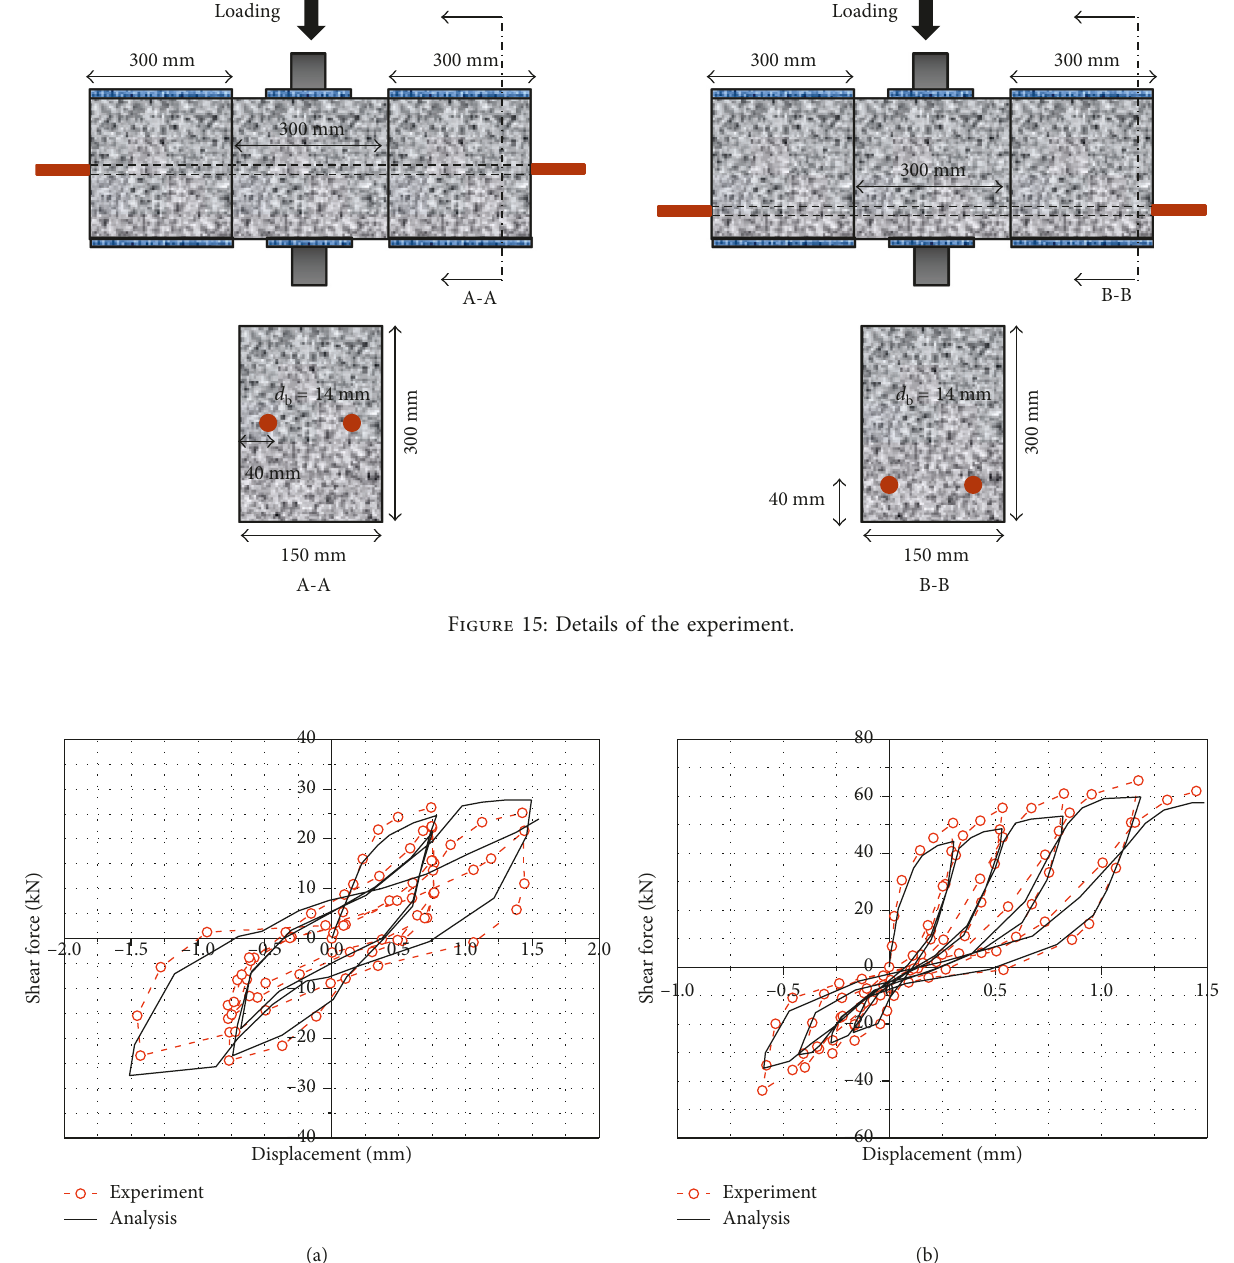
Figure 16: Comparison of FE analysis results and experimental data: (a) specimen A (the concrete cover is 143mm); (b) specimen B (the concrete cover is